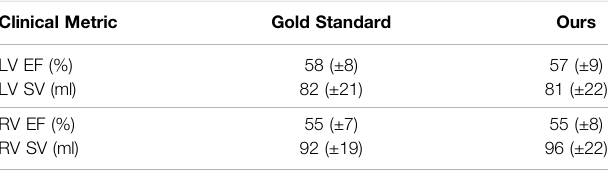
TABLE 5 | Clinical function metrics of meshed point clouds generated by our method. Clinical Metric